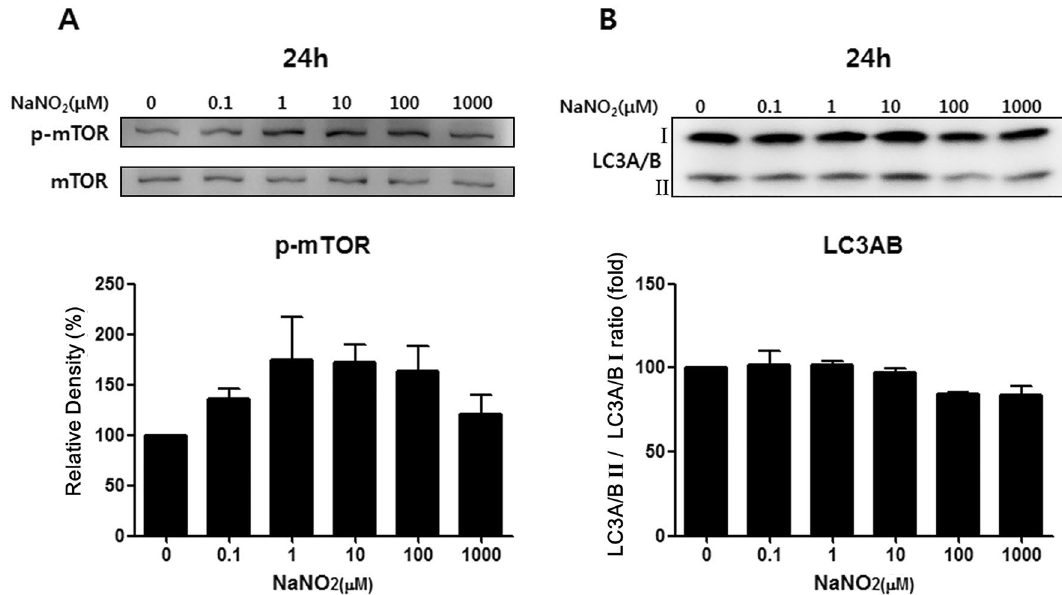
Figure 3. Sodium nitrite’s effect on two critical cellular survival pathways, mTOR and autophagy, was tested by Western blot. Phosphorylated mTOR is the activation of the mTOR pathway, while autophagy’s activation is represented by increases in LC3AB II forms. Sodium nitrite did not harm mTOR ( A ) and the autophagy pathway ( B ) of keratocytes up to 1 mM concentration for 24 h. Note that only the bands at the adequate molecular weights were shown here. Full length gel and blots are included in the Supplementary